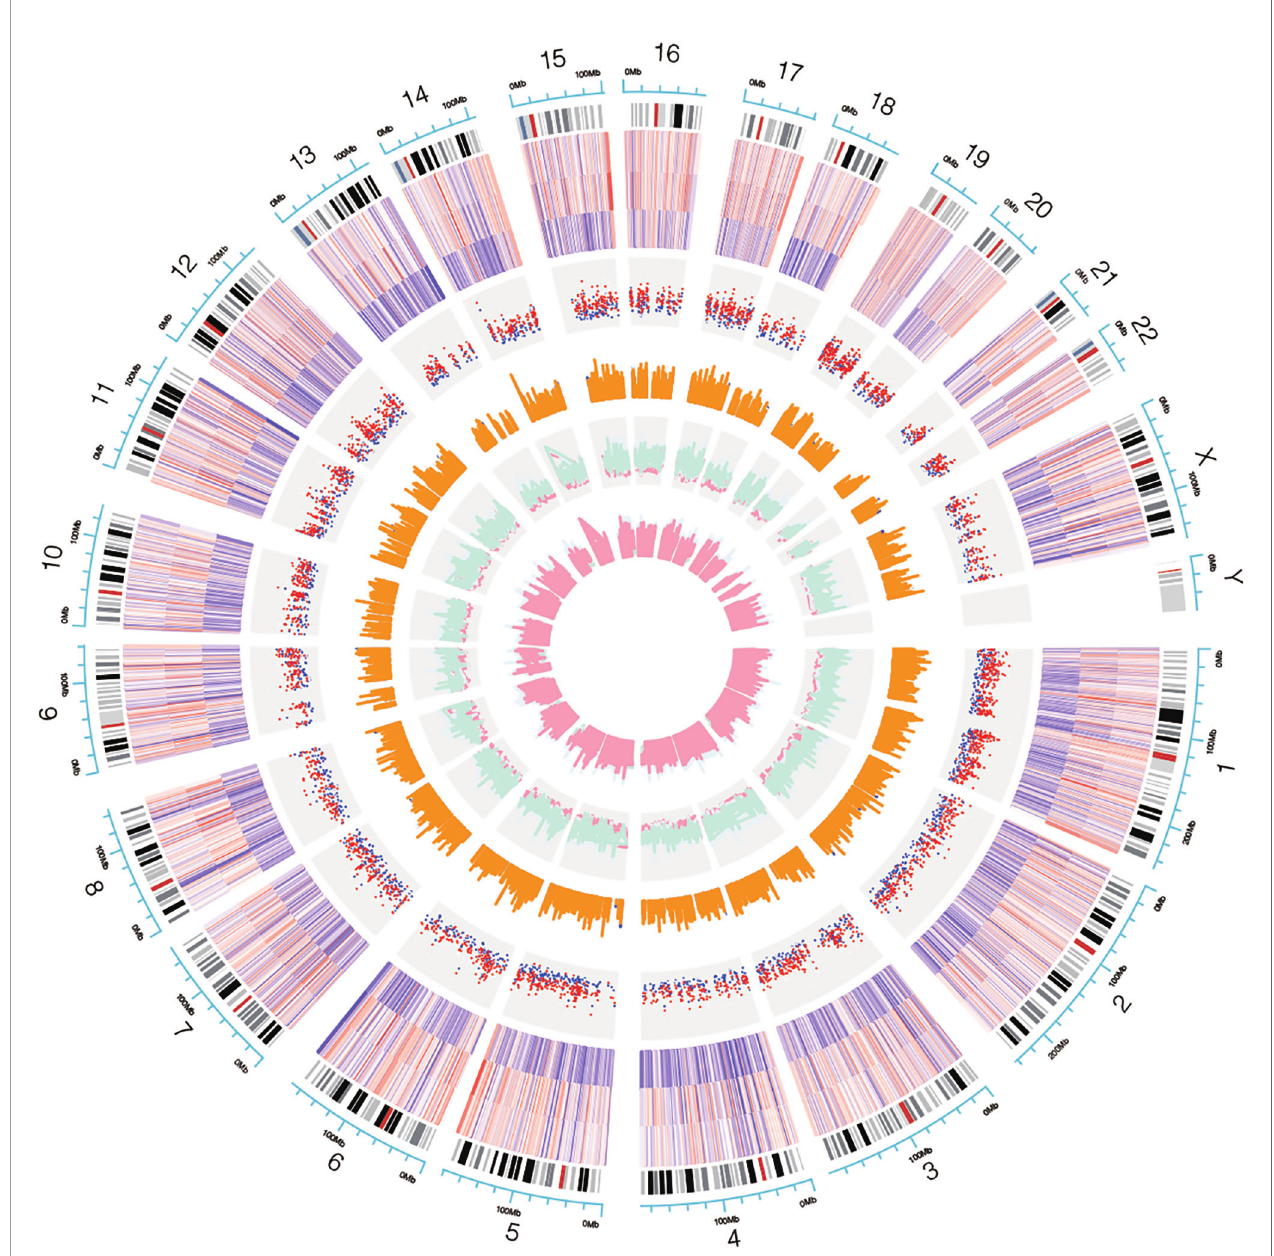
FIGURE 1 | Chromosomal distribution of the candidate circRNAs. Chromosomes 1, 2, 3 and X contained more circRNAs than the other